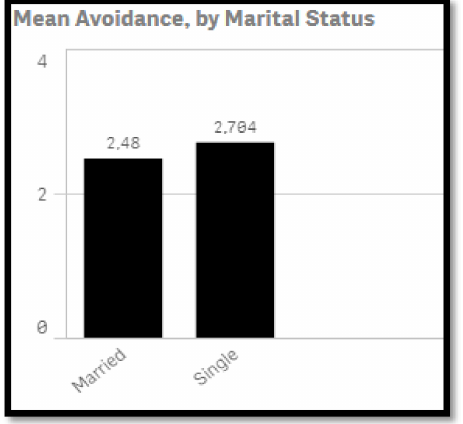
Figure 8. Avoidance, by Marital Status. Source: data study